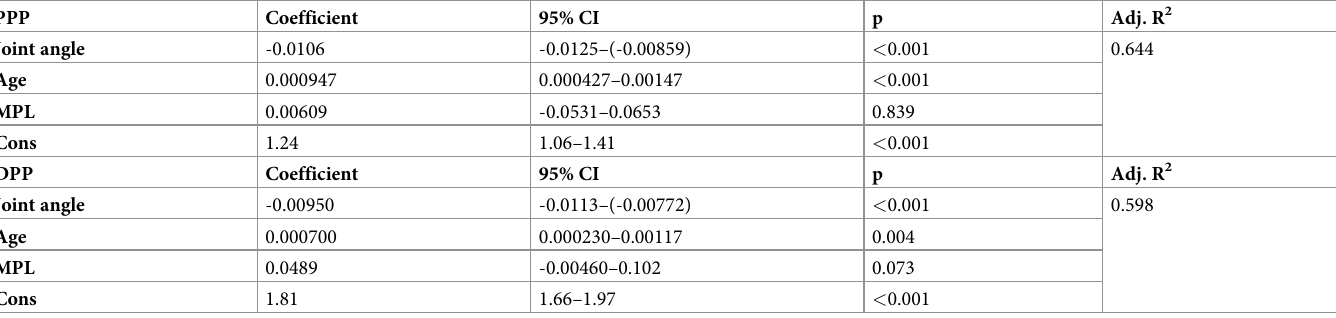
Table 5. Final models of multivariable linear regression analyses for PPP or DPP and the presence of